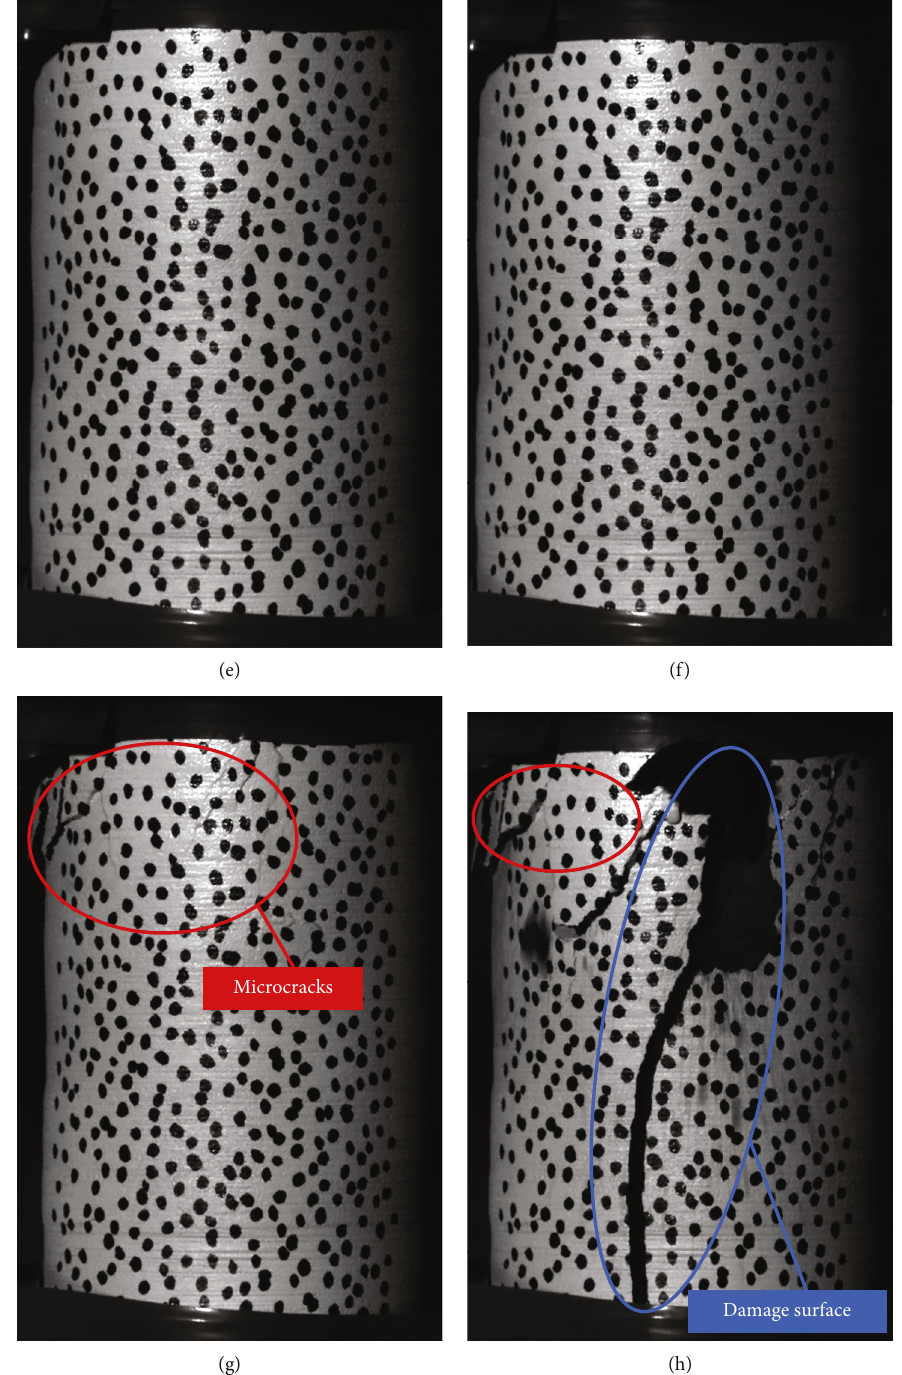
Figure 7: (a ~ d) AE source location and spatial evolution of rock sample U7-2 at di ff erent loading stages. (e ~ h) Physical images corresponding to the AE source location at di ff erent loading